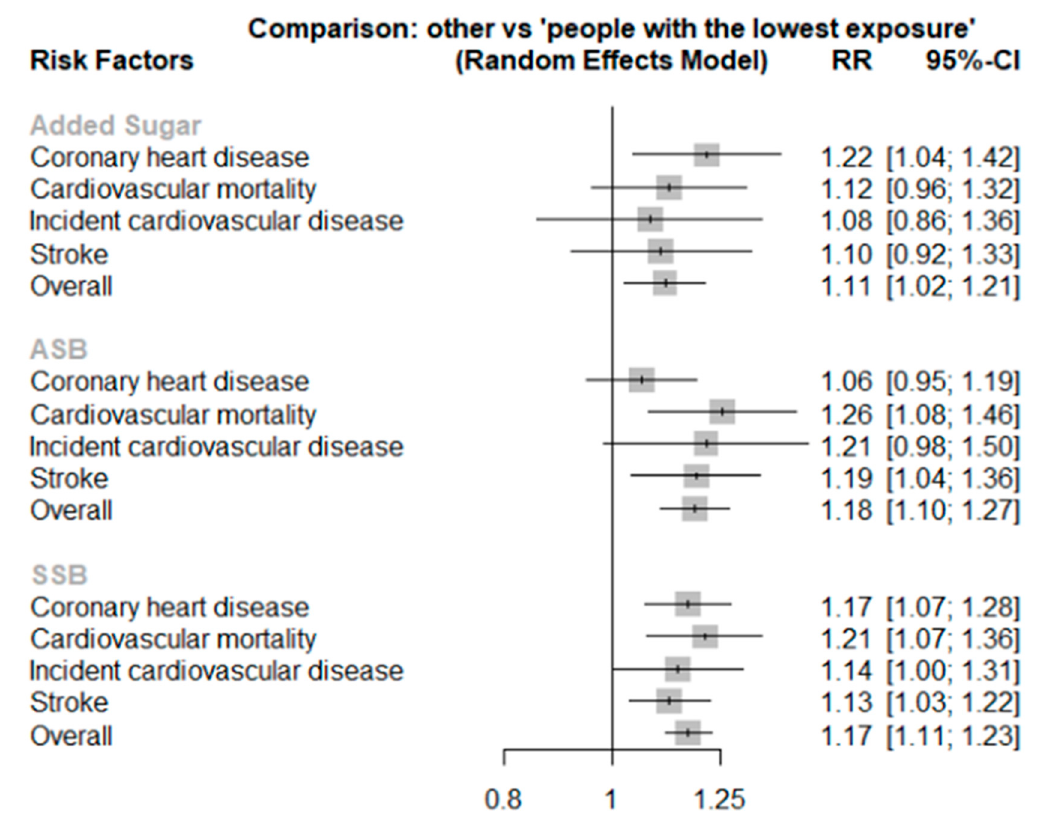
Figure 2. Random effects network meta-analyses on added sugar, SSB, ASB, and the risk of cardiovascular outcomes. The network meta-analysis was performed using frequentist methods with a random effects model. The study effect sizes for the highest versus the lowest category of exposure were calculated. Abbreviations: ASB, artificially sweetened beverages; RR, relative risk; SSB, sugar-sweetened beverages.